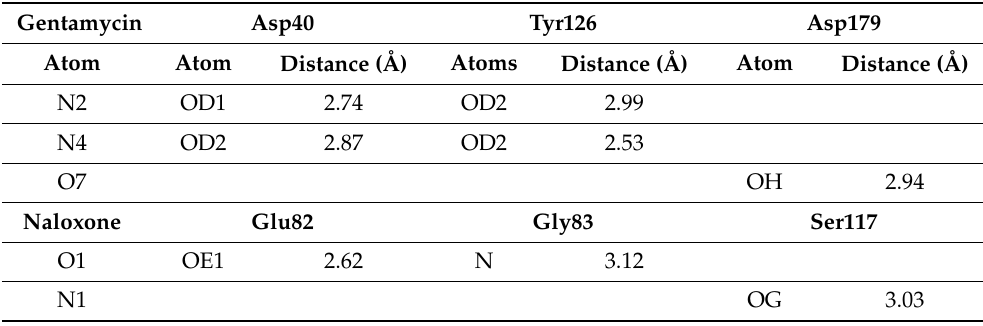
Table 4. Protein-ligand hydrogen bond interaction profile.